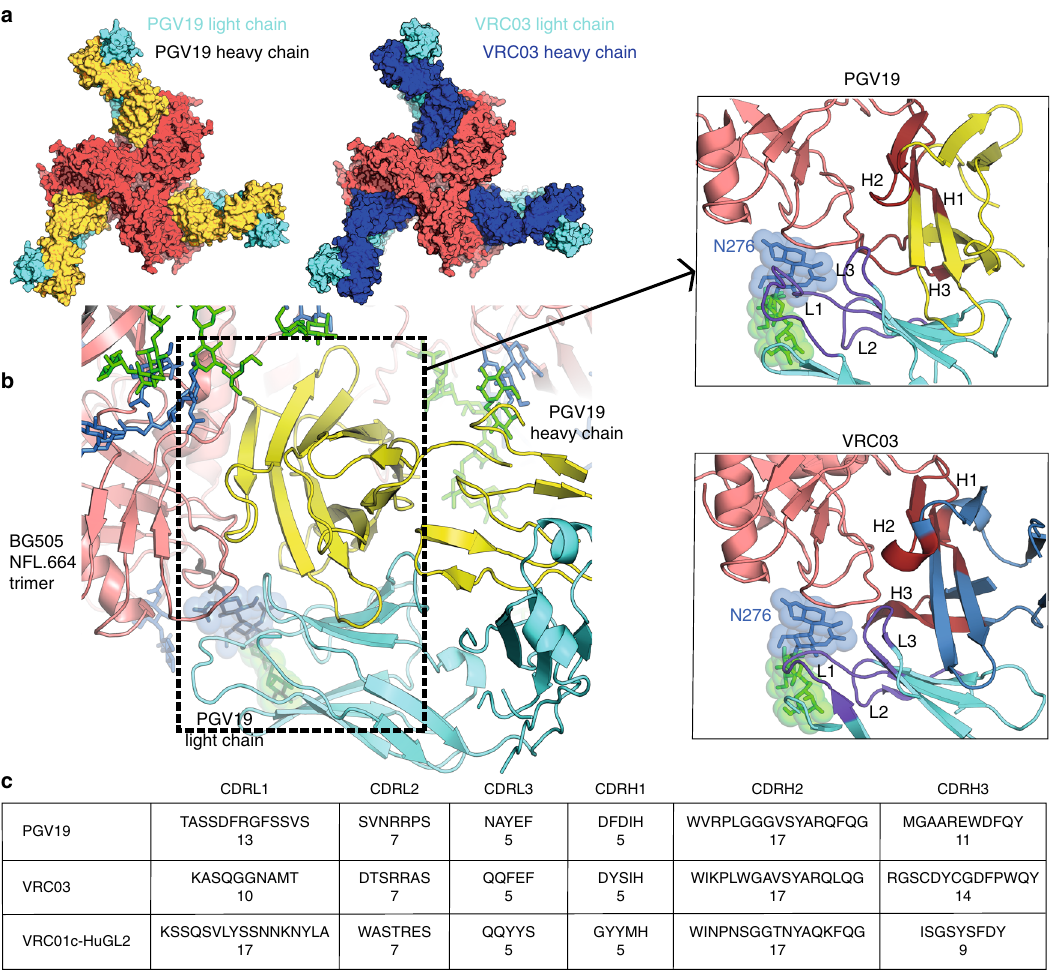
Fig. 7 Similarities and differences between VRC01-class lambda and kappa antibodies. a Top view in surface representation of the BG505 NFL.664 trimer in complex with PGV19 (crystal structure; HC: yellow, LC: cyan) and VRC03 (model based on EM map; HC: dark blue, LC: cyan) used in this study for crystallography and cryoEM experiments, respectively. b CD4bs interactions of PGV19 with BG505 NFL.664 as observed in the crystal structure. Inset: The lambda (PGV19) and kappa (VRC03) light chains both evolved a short CDRL3 to accommodate the N276 glycan, and CDRH1 is less than 11 residues to prevent clashes with the V5 gp120 loop in Env (CDRHs: brown, CDRLs: purple). c Comparison of the CDR loop lengths of PGV19 and VRC03 50 from HIV + elite neutralizers and a naïve VRC01c-HuGL2 31 from an HIV-uninfected